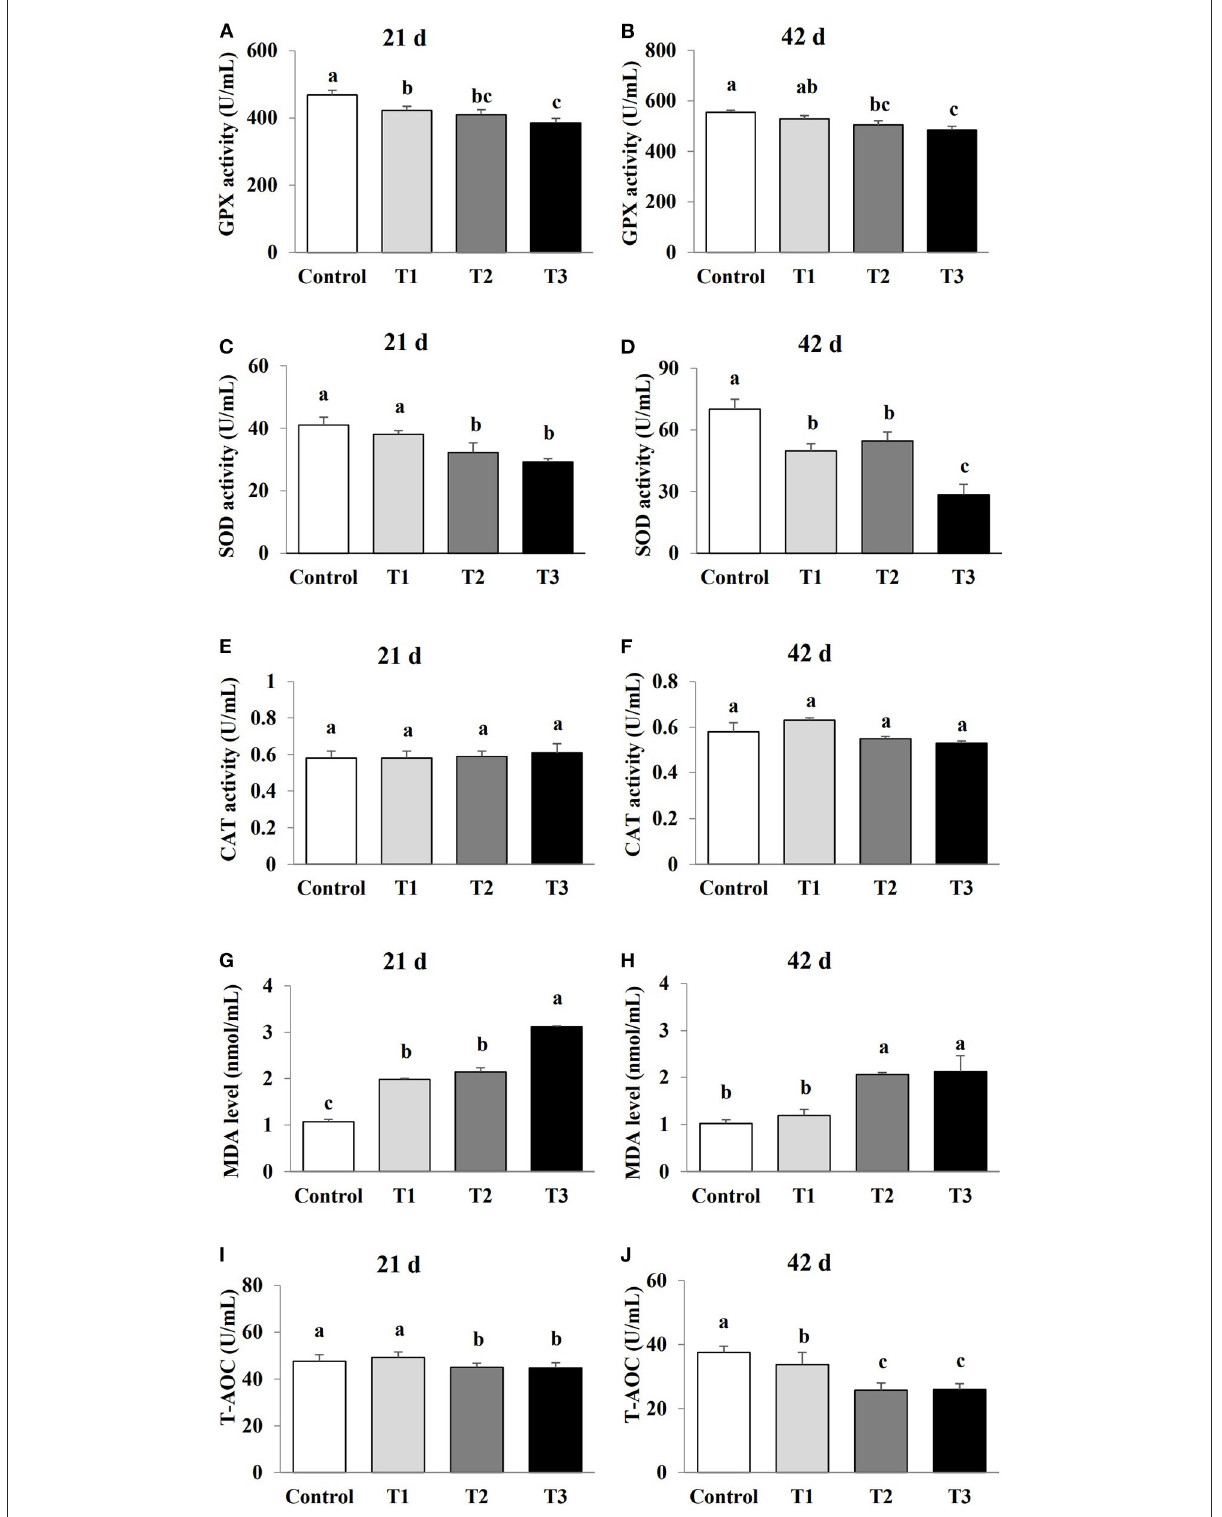
FIGURE2 Effects of AFB 1 on the antioxidant parameters in serum of chicks on day 21 and day 42. (A) GPX activity on day 21. (B) GPX activity on day 42. (C) SOD activity on day 21. (D) SOD activity on day 42. (E) CAT activity on day 21. (F) CAT activity on day 42. (G) MDA content on day 21. (H)